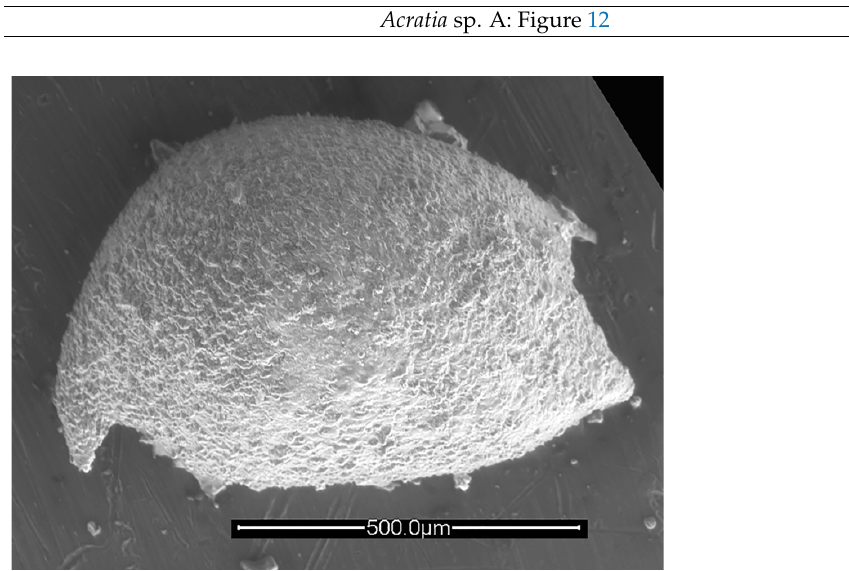
Figure 12. Acratia sp. A, left valve, lateral view. IGM 5011(8). Scanning electron micrograph (sec- ondary electrons). Scale bar = 500 microns. (secondary electrons). Scale bar = 500